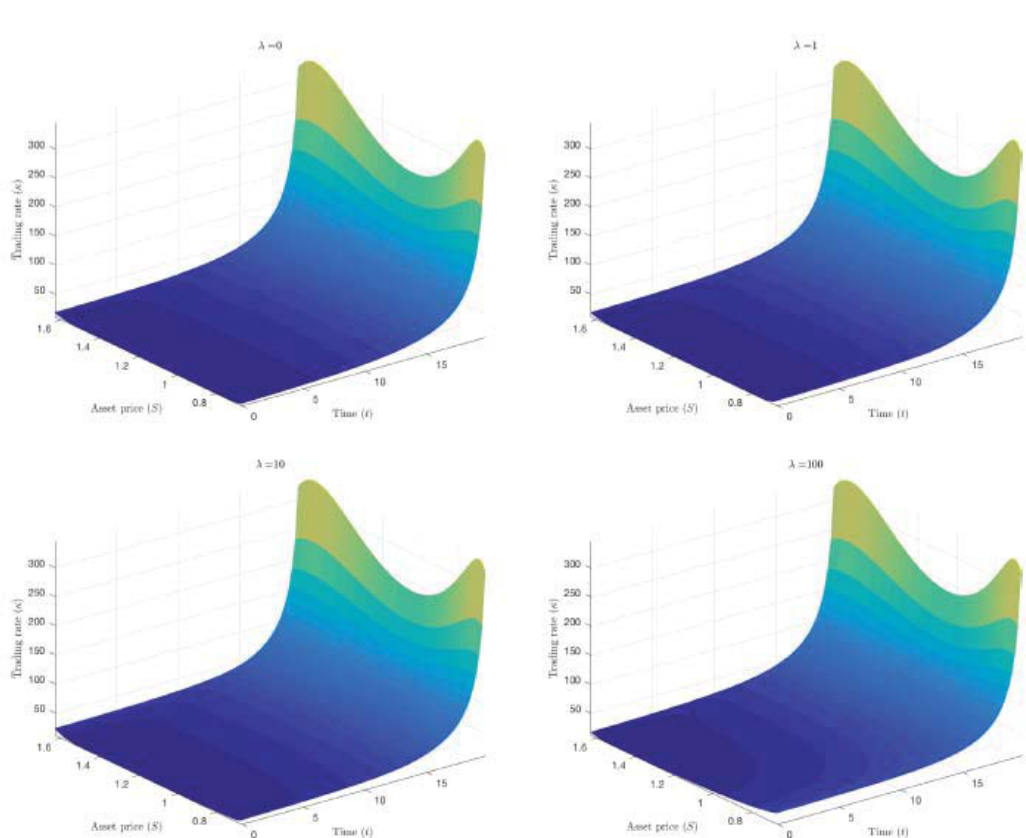
Fig. 7. The rate of trading as a function of the underlying price S and time t for different values of (cid:540) : mean objective ( (cid:540) = 0 top left) or mean-variance ( (cid:540) =1 top right, 10 bottom left, 100 bottom